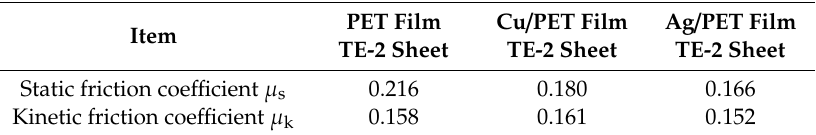
Table 2. Friction coe ffi cients between